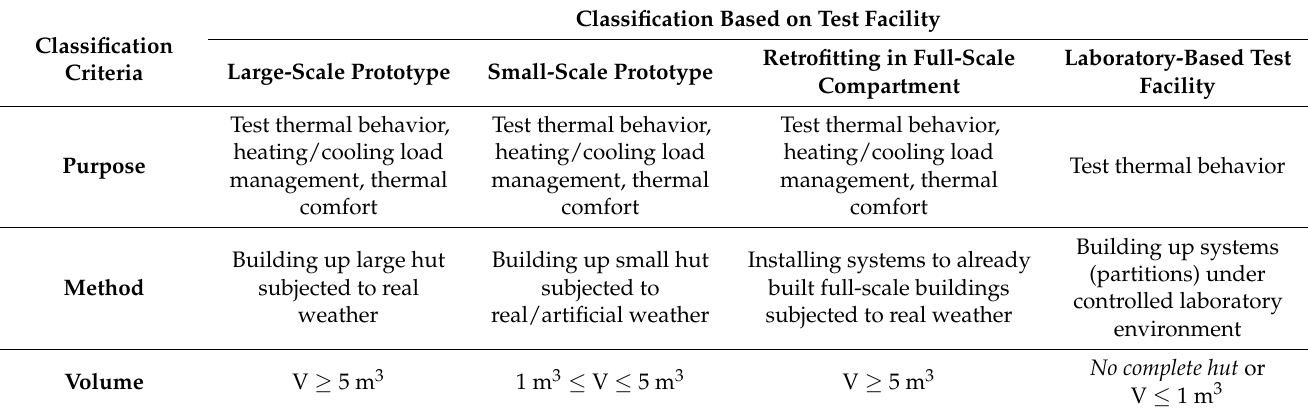
Table 1. Experimental studies classification based on test facility and the followed